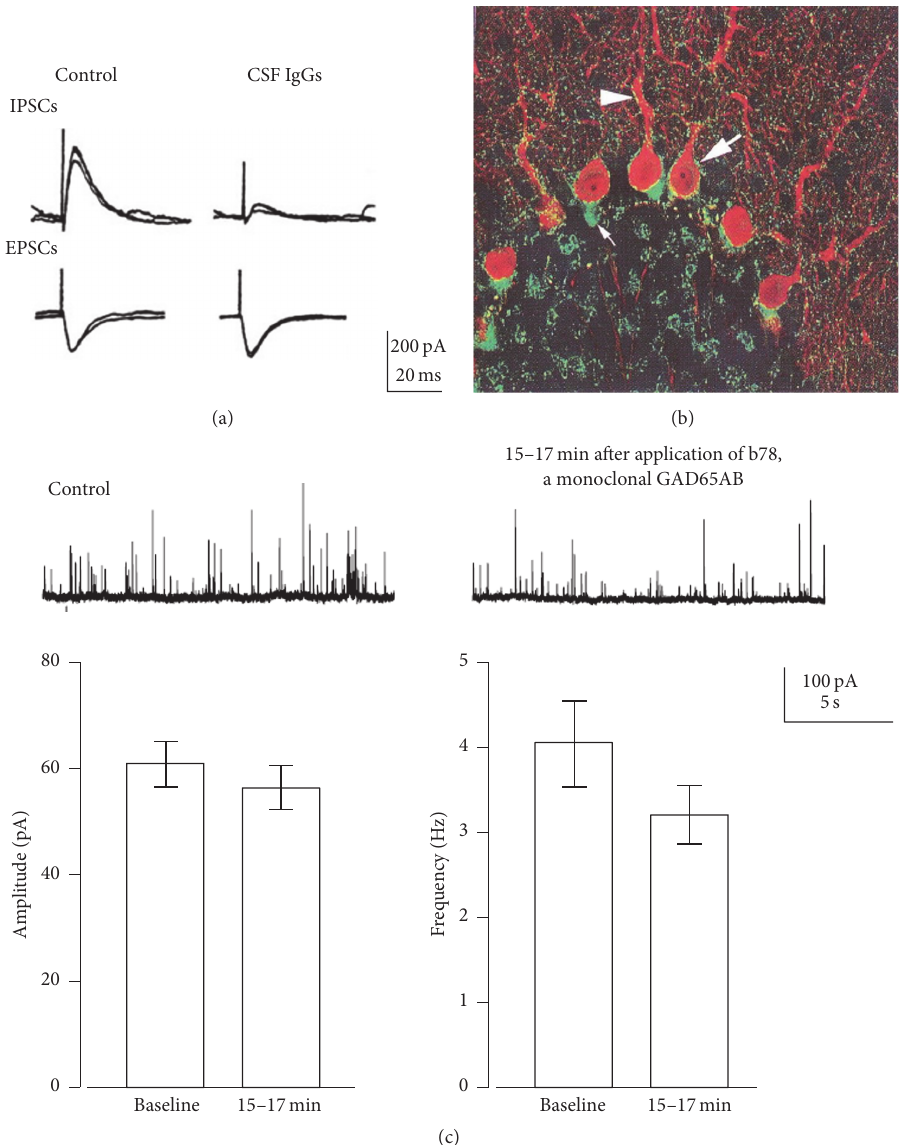
Figure 2: Pathogenic actions of CSF IgGs from GAD65Ab-positive CA and human monoclonal GAD65Ab b78 in cerebellar slices prepared from rats and mice. (a) Electrical stimulation in the cerebellar cortex induces GABA-mediated inhibitory postsynaptic currents (IPSCs) and glutamate-mediated excitatory postsynaptic currents (EPSCs) in a PC. The CSF IgGs depressed IPSCs without affecting EPSCs. Two sweeps are superimposed. (b) Immunoreactivities of CSF IgGs were observed in the presynaptic terminals of GABAergic interneurons and not the postsynaptic PC. Large and small white arrows indicate punctate immunoreactivity in the rim of the somata and high density of immunoreactivity terminals in the initial segment of PC, respectively. Arrowhead indicates immunoreactivity along with dendritic shaft. (c) b78-induced impairment in GABA release: decreased amplitudes of miniature IPSCs, reduced GABA content in vesicles, and reduction of frequency of miniature IPSCs, and the release probability of GABAergic vesicles. Two sweeps (grey and black) are superimposed. Data are mean ± SEM of 12 experiments. These figures were modified from our previous references [7, 30,